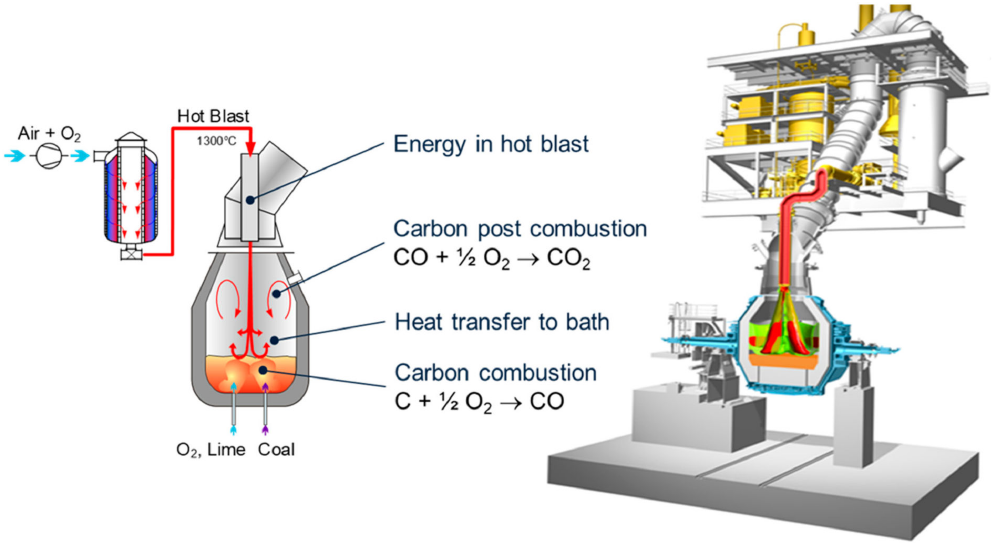
Figure 15. Process scheme of the Jet Process. Reprinted with permission from Ref. [71], 2022, Primetals.